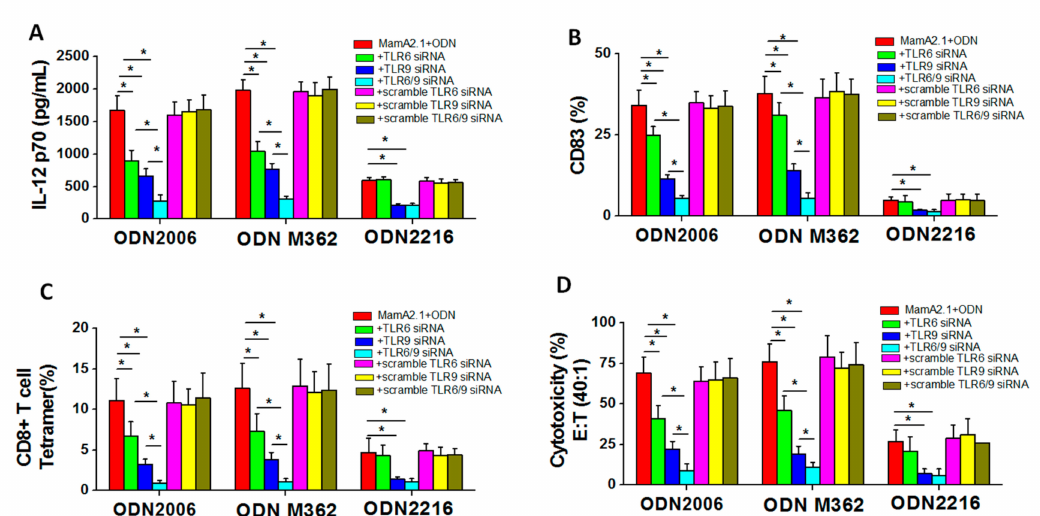
Figure 6. Expression of the cytokine of phenotypic di ff erentiation markers following TLR-6 and / or -9 knock down along with co-treatment of the MamA2.1 peptide and various ODNs. The IL-12 cytokine release ( A ) and the expression maturation marker CD83 ( B ) in THP-1 cells following various treatment conditions. The ability of these stimulated THP-1 cells to induce cytotoxic CD8 + T cell responses was studied by tetramer staining ( C ) and cytotoxicity on AU565 breast cancer cells ( D ). All experiments were performed in four independent replicates, and data are expressed as mean ± SD, * p < 0.05 compared with the MamA2.1 peptide treatment